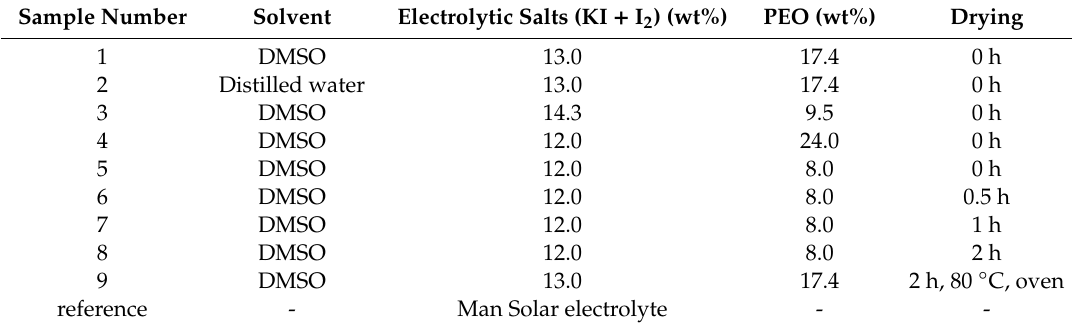
Table 1. Overview of the samples with the respective compositions of the PEO-based gel electrolytes. Sample Number Solvent Electrolytic Salts (KI + I 2 ) (wt%) PEO (wt%)